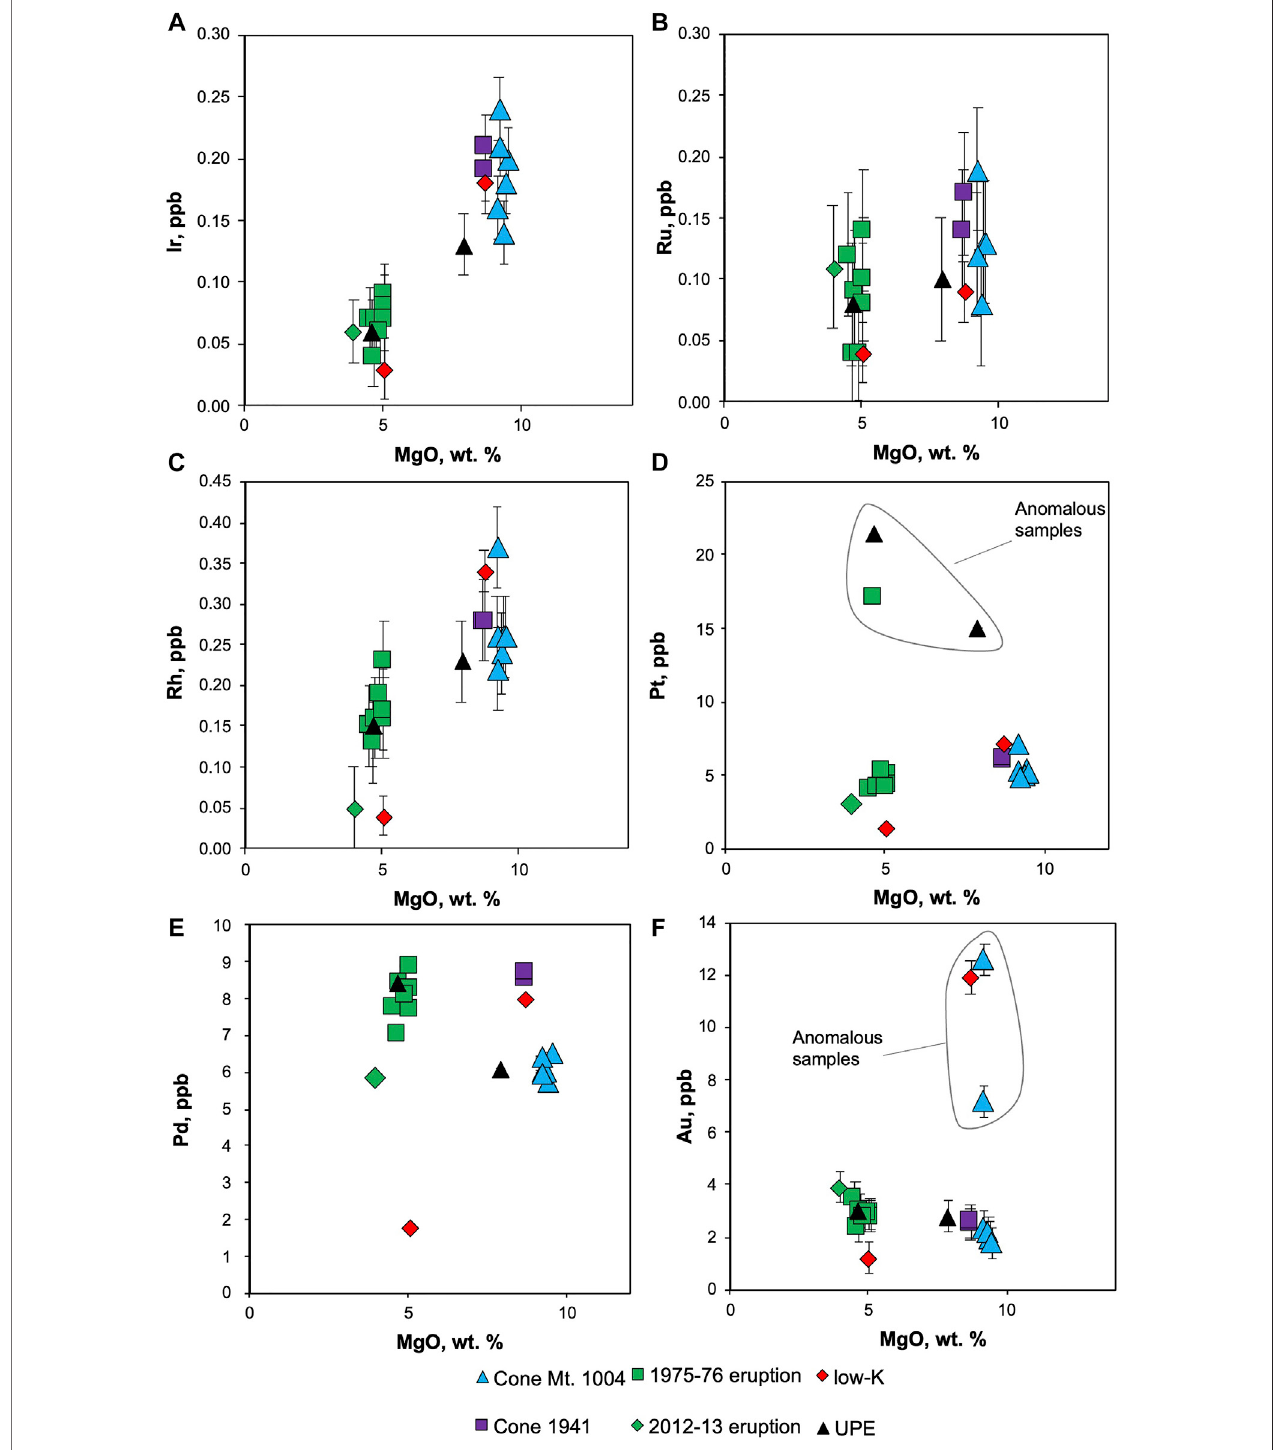
FIGURE4| Platinum-groupelementvariationacrossdifferentMgOcontentsforTolbachiklavas.ErrorbarsareprovidedforIr,Ru,RhandAu;forPtandPdtheyare smaller than the size of a symbol.